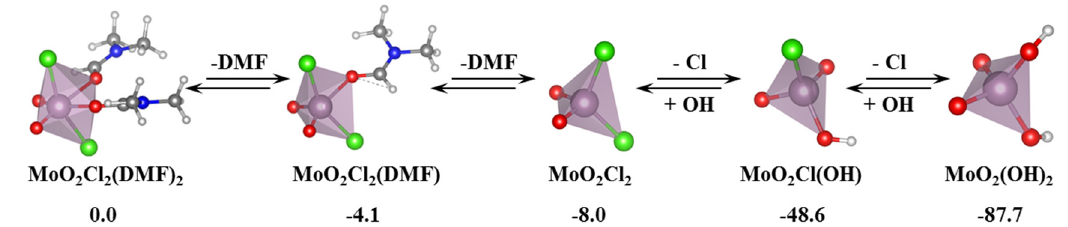
Figure 38. Summary of the most important species that can be formed in solution by ligand release, hydrolysis of Mo-Cl bond and acidification of the media. The relative Gibbs free energies at BP86/TZ2P/COSMO are in kcal mol − 1 .